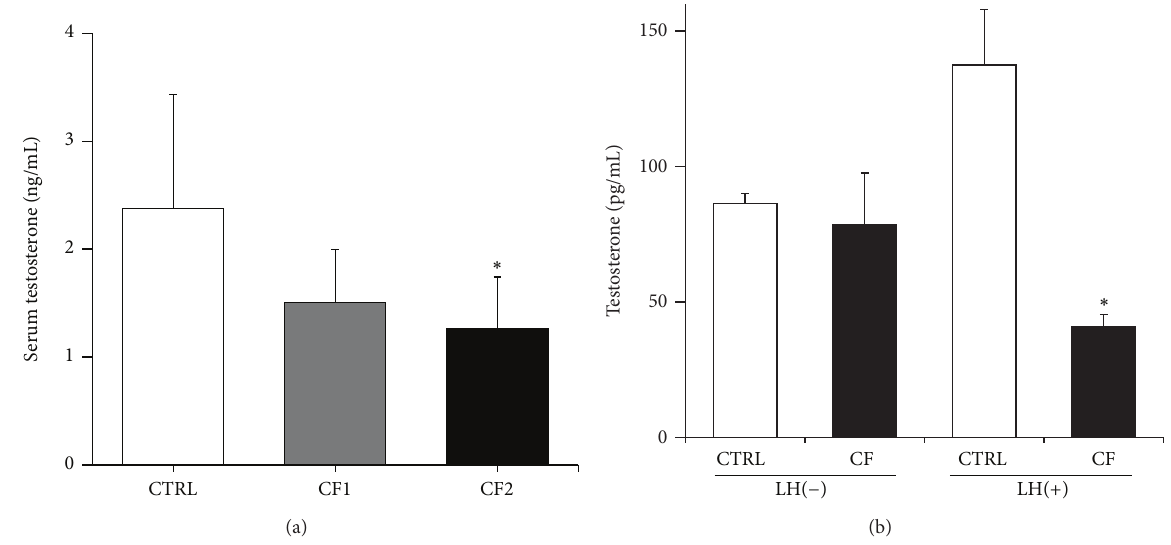
Figure 5: Effect of caffeine on serum testosterone levels and endogenous Leydig cell testosterone production. (a) Serum concentration of testosterone in the control and caffeine-fed groups after 4 weeks of caffeine exposure. Data are presented as mean ± SD based on two independent measurements. CTRL, control; CF1, 120mg caffeine-fed; CF2, 180mg caffeine-fed. ∗ 𝑝 < 0.05 versus CTRL. (b) Testosterone production with or without LH (200ng/mL) in rat primary Leydig cells retrieved from the control and caffeine-fed animals at 4 weeks of caffeine exposure. Data are presented as mean ± SD based on two independent measurements. CTRL, Leydig cells retrieved from the control animals; CF, Leydig cells retrieved from caffeine-fed animals (120 mg/kg/day). ∗ 𝑝 < 0.05 versus